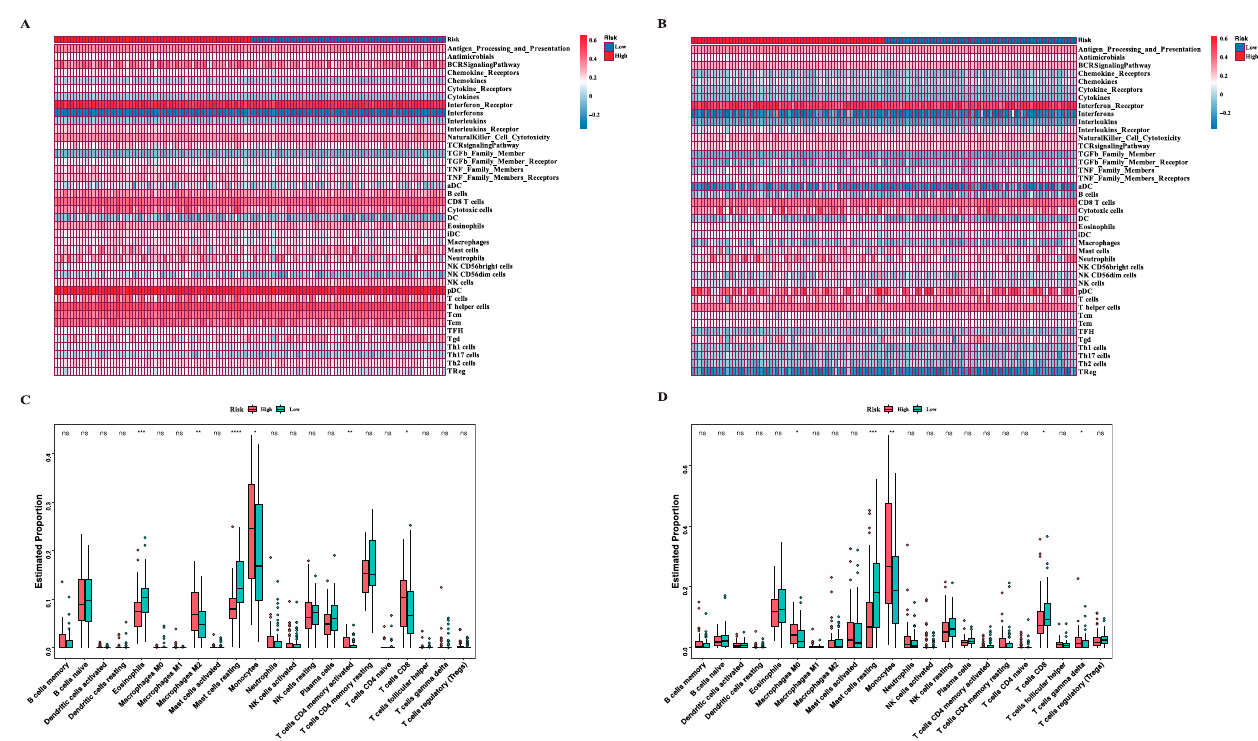
Figure 7. Landscape of immune activity and relevant infiltrating immune cells in the two risk subgroups. ( A , B ) Heatmap showing the ssGSEA enrichment scores of 40 immune components including immune cells, relative immune factors and pathways in TCGA ( A ) and GSE37642 ( B ) cohorts. ( C , D ) Comparisons of proportion of 22 immune cells between the two risk subgroups in TCGA ( C ) and GSE37642 ( D ) cohorts (Wilcox text, * p < 0.05; ** p < 0.01; *** p < 0.001, **** p < 0.0005).